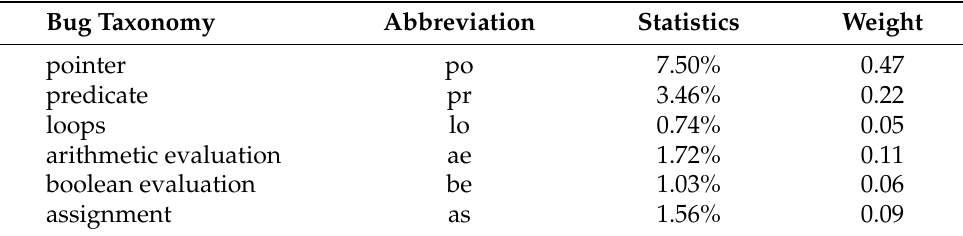
Table 1. Bug statistics.